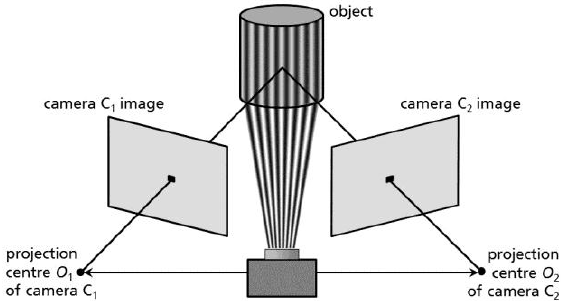
Figure 1: Stereo camera arrangement with fringe